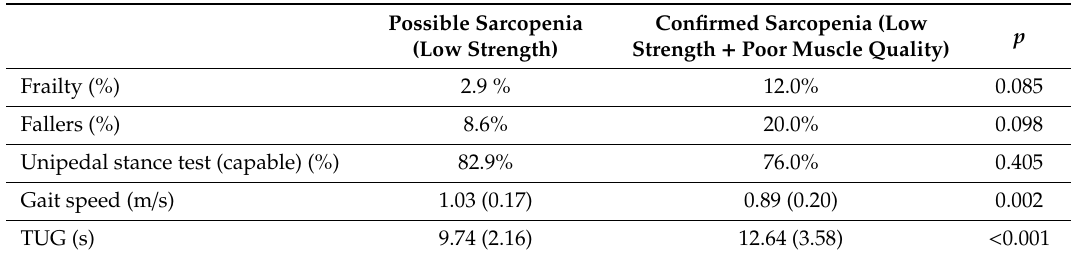
Table 5. Comparison of frailty and physical performance indicators between subjects with possible sarcopenia and subjects with confirmed